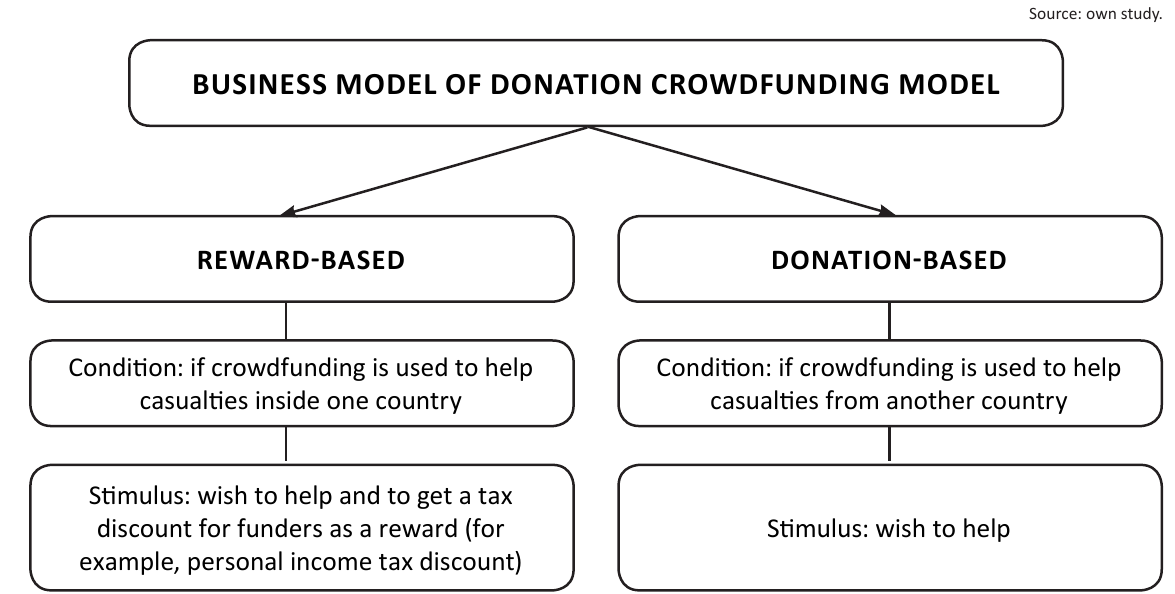
Figure 1. S�mulus for individuals to take part in crowdfunding for financing losses from natural and man-made